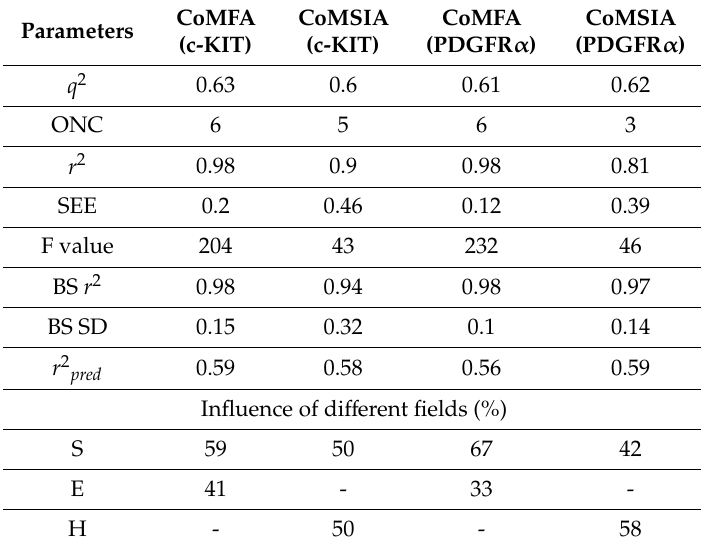
Table 4. Statistical results of the comparative molecular field analysis (CoMFA) and comparative molecular similarity indices analysis (CoMSIA) models for c-KIT and PDGFR α